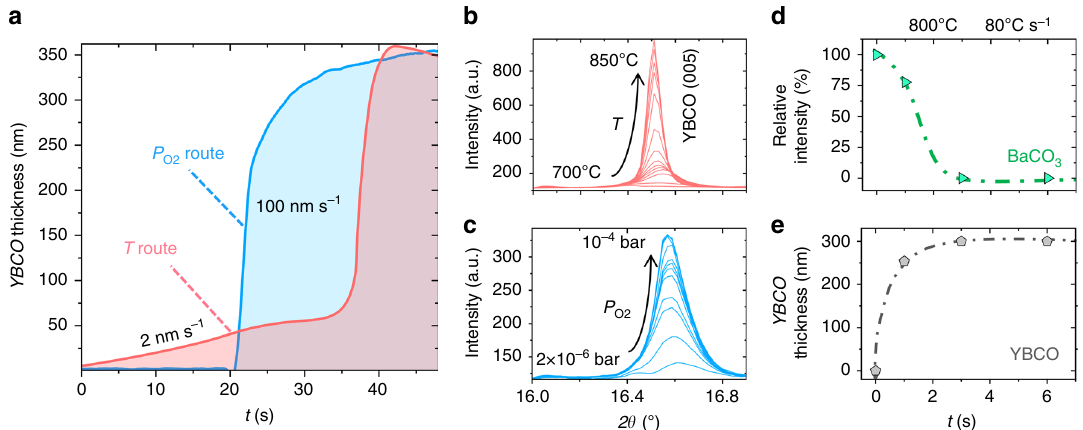
Fig. 2 Fast evolution of phases in TLAG by in situ XRD synchrotron radiation. a YBCO growth rate determined from in situ XRD synchrotron analysis of a 350 nm fi lm demonstrating 100 nm s − 1 growth rate for T-route ( P O2 = 10 − 3 bar, dT/dt = 5 °C s − 1 ) and P O2 -route ( T = 850 °C, P O2,base = 10 − 5 bar, P = 10 − 2 bar). Initial stages for the T-route show a growth rate of 2 nm s − 1 . b , c Evolution of the diffracted intensity of the (005) YBCO peak for O2, fi nal the T-route and P O2 -route, respectively, during the transformation for the experiment reported in a . The X-ray energy used for these measurements was 18 keV. The evolution with time of the XRD intensity for d BaCO 3 and e YBCO phases in a T-route process in a RTA furnace at 800°C ( P O2 = 10 − 2 bar, dT/dt = 80 °C s − 1 ) for a fi lm of 300 nm. Notice that BaCO 3 consumption to form the transient liquid goes in parallel with YBCO growth, which reaches completion in 3 s in these